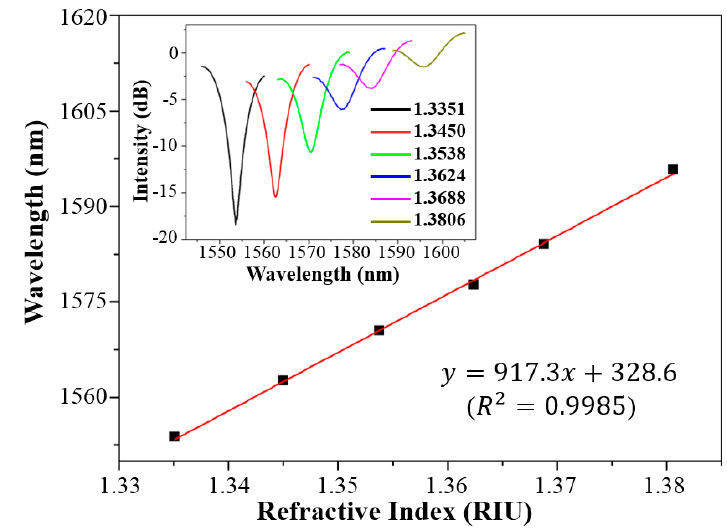
Figure 6. Response of a spectral dip of the optical fiber-tip sensor to the RI change of surrounding liquid. Inset shows the spectrum evolution of the spectral dip under monitoring.